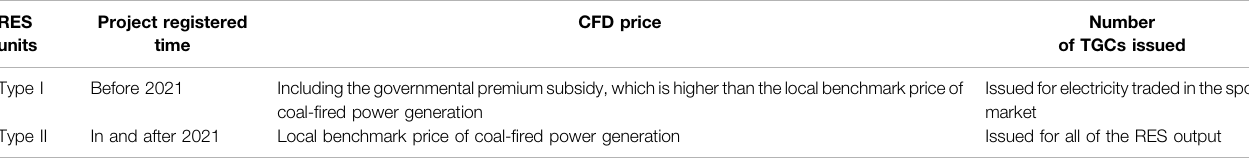
TABLE 1 | Comparison of the two types of RES